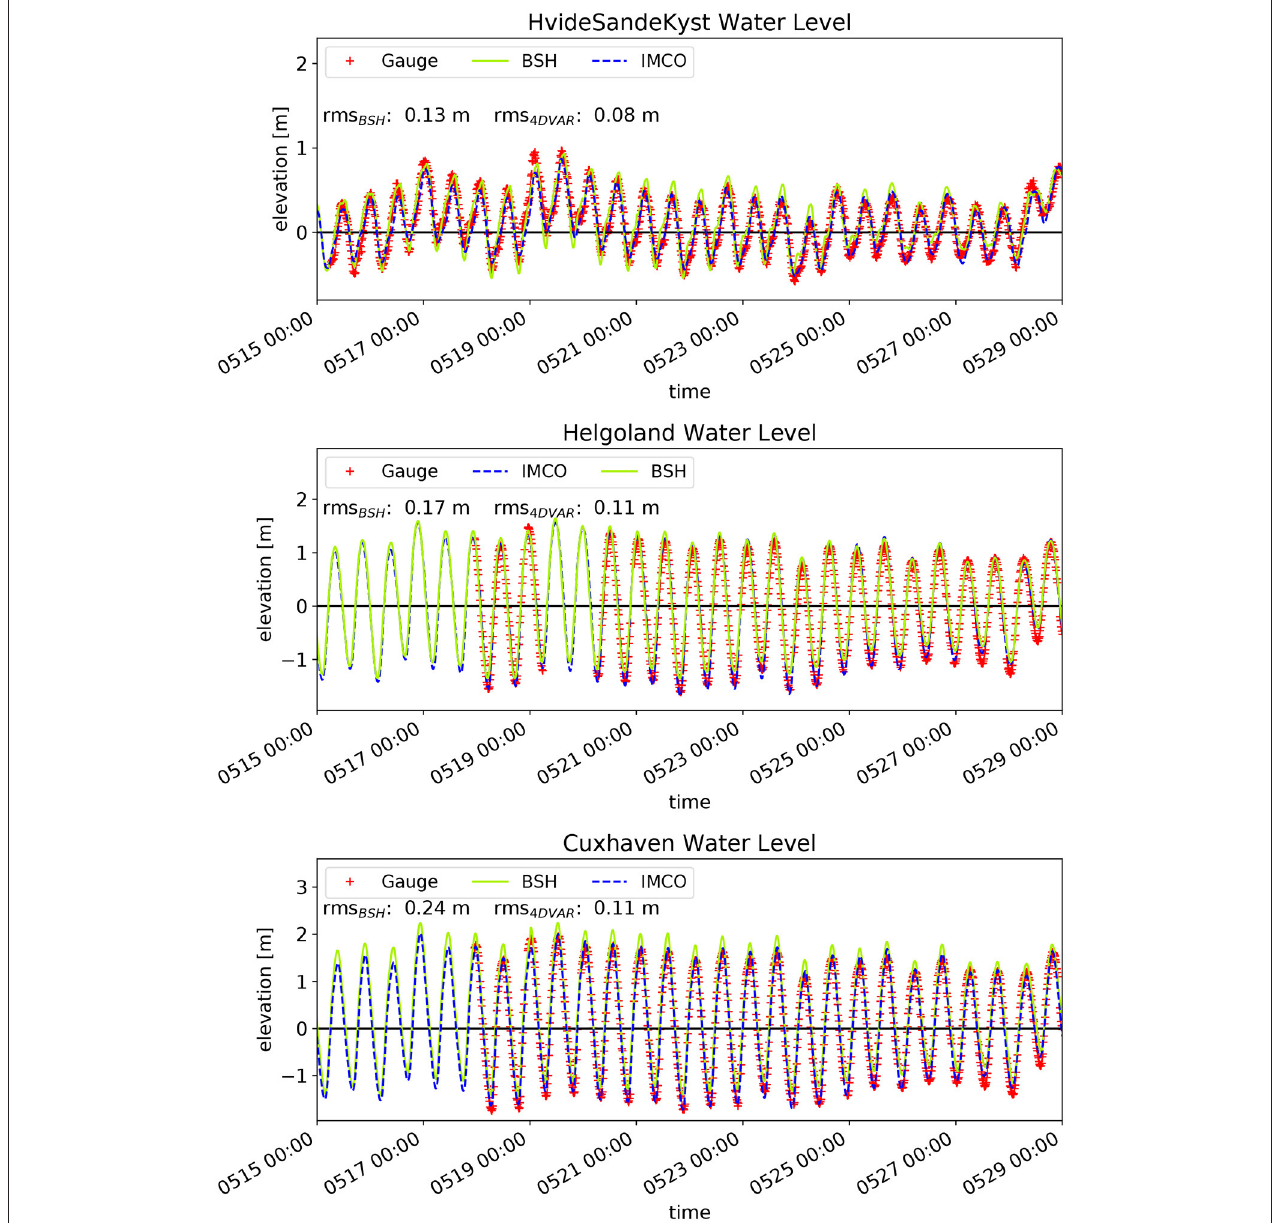
FIGURE 4 | Comparisons of water levels at the tide gauge stations HvideSandeKyst (top) , Helgoland (middle) , and Cuxhaven (bottom) for the period May 15–May 29, 2015. Red crosses indicate measurements and green and blue curves correspond to the BSH model and the 4DVAR results,